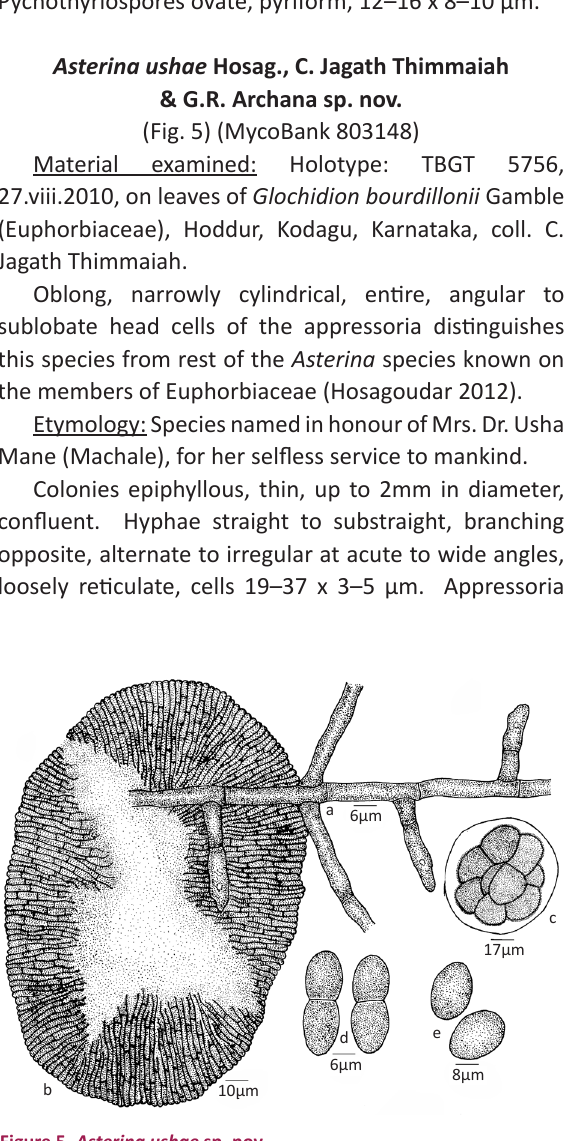
Figure 4. Asterina hemidesmi sp. nov. a - Appressoriate mycelium; b - Thyriothecium; c - Ascus; d - Ascospores